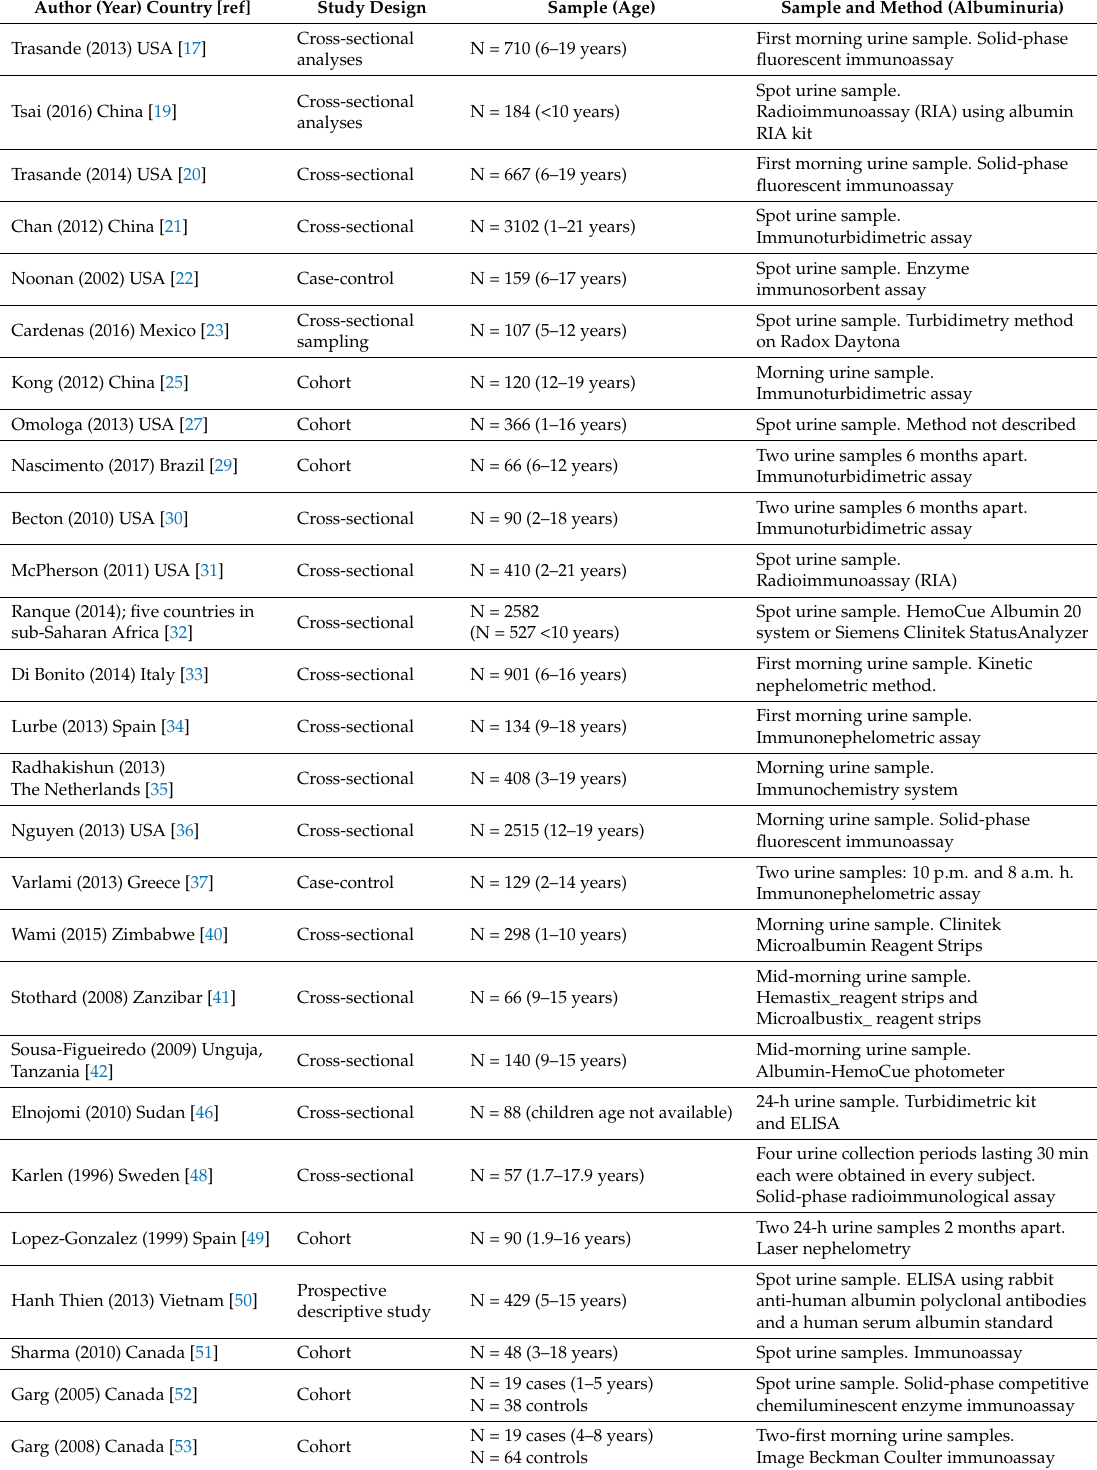
Table 2. Characteristics of the studies that only included subjects under 21 years